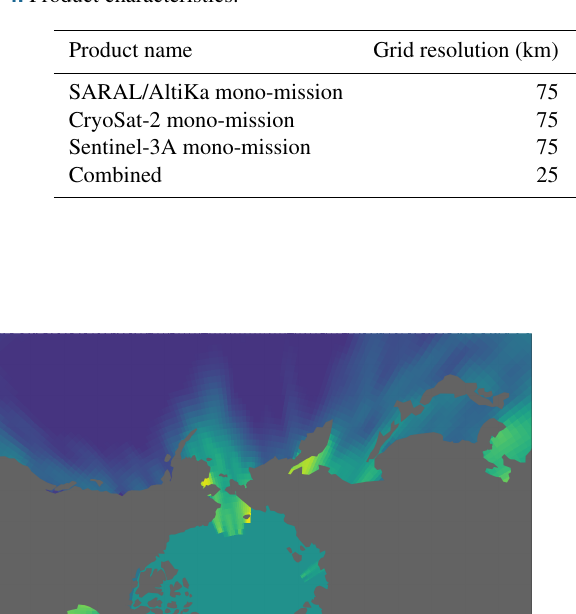
Figure 5. Noise levels over open ocean (a) and ice-covered (b) areas used in the regional analysis. Table 4. Product characteristics.